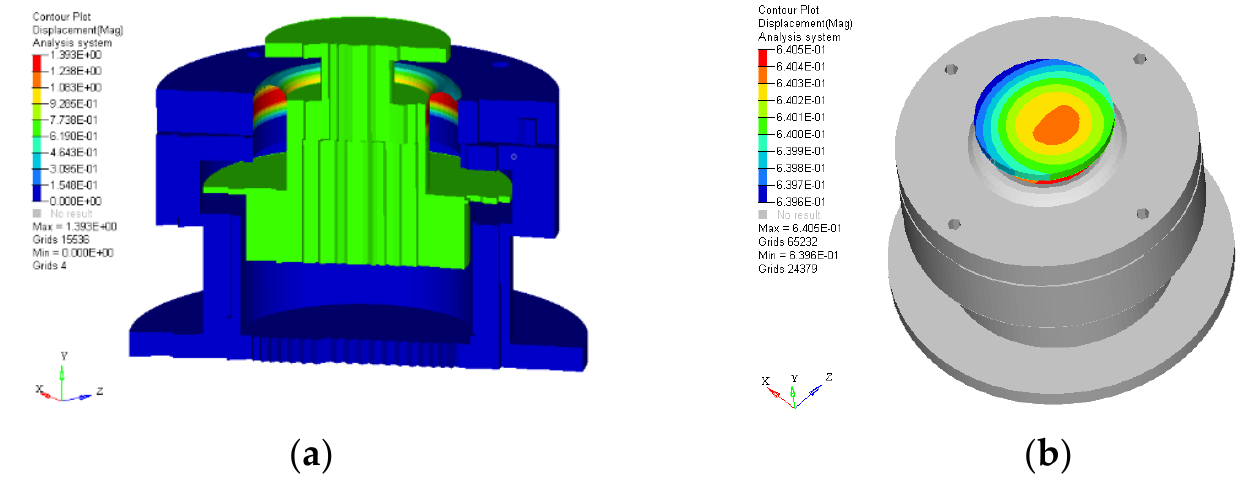
Figure 6. ( a ) Overall deformation cloud diagram of HSU; ( b ) deformation cloud diagram of the floating parts.